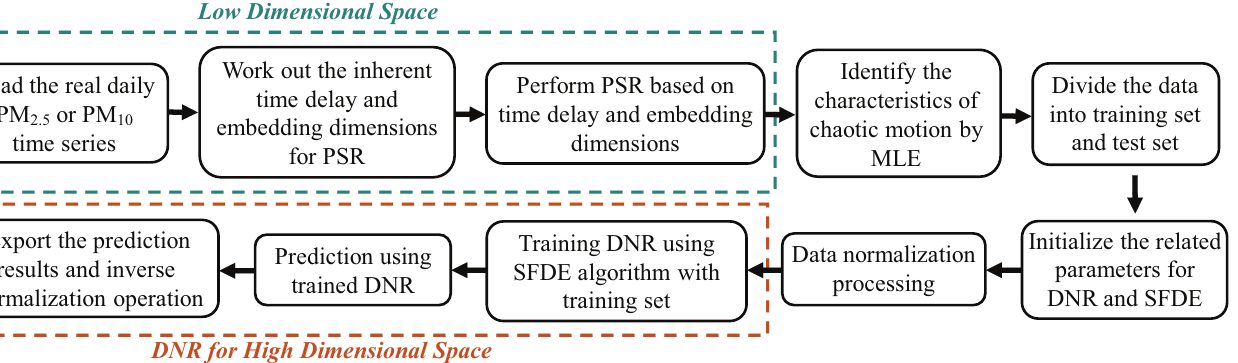
Figure 4. Air quality estimation framework based on